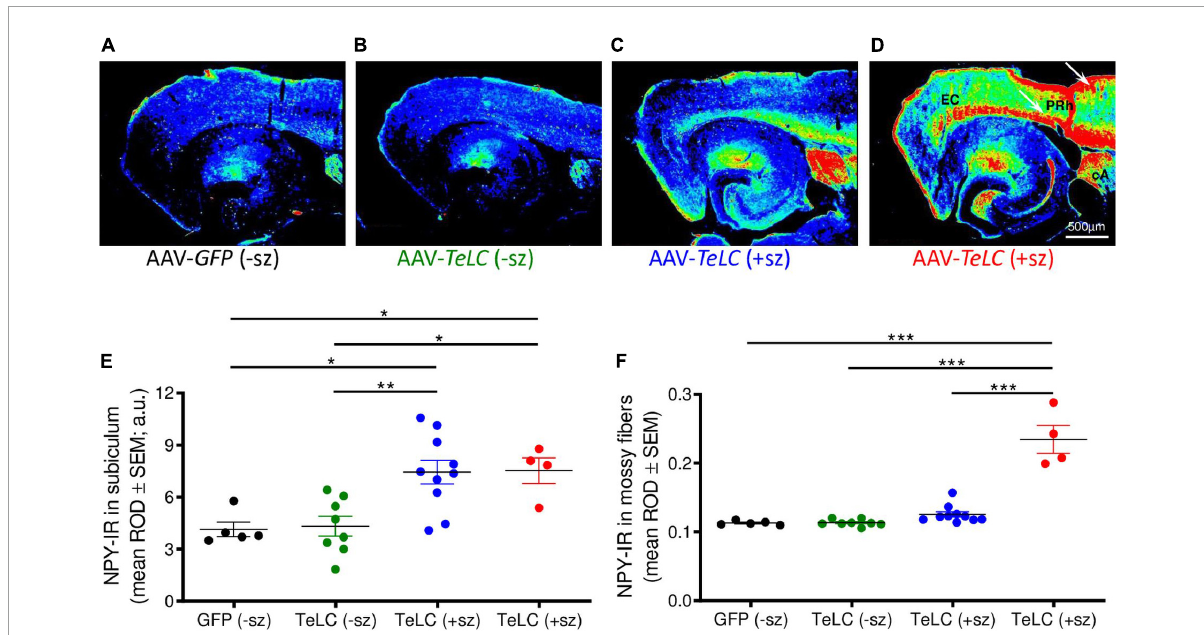
FIGURE4 NPY overexpression in mice experiencing SRS but not in mice with clusters of IS. NPY-IR was assessed in horizontal brain slices at the level of the ventral subiculum/hippocampus in mice 42 days after injection with AAV- GFP or AAV- TeLC , respectively (Experiment 1). Panels (A–D) show false color images of NPY-IR representative for: (A) a control (AAV- GFP -injected, black); (B) representative mouse presenting only IS clusters after AAV- TeLC injection (green, mouse #3425); (C) a mouse that experienced SRS during days 10–30 (blue, mouse #1088); and (D) a mouse with seizures (3) after day 32 (red, mouse #1062). (E,F) Corresponding to the labeling of the images above, the first column in panels (E,F) shows data of control mice without SRS. Note the pronounced increase in NPY-IR in the subiculum, both in mice with seizures up to day 30 (C) and during 10 days before sacrificing (D) . Note also the strong increases in NPY-IR in cortical areas in epileptic mice [ (C) , white arrows in panel (D) ]. Black: AAV- GFP -injected controls ( n = 5); green: AAV- TeLC -injected mice with IS only ( n = 8); blue: mice that experienced SRS only in the first 32 days after AAV- TeLC injection (thus, were at least 10 days seizure-free before sacrificing) ( n = 10); red: mice that experienced SRS within 5 days before sacrificing ( n = 4). Note that the increase in NPY-IR persists in the subiculum of mice that experienced SRS only at earlier intervals [up to day 32 after vector injection; filled blue circles in panel (E) ]. In contrast, increased expression of NPY-IR was observed in the dentate gyrus only in mice that showed SRS also within the last 5 days before sacrificing [filled red circles in panel (F) ]. Letters in panel (D) : EC, entorhinal cortex, PRh, perirhinal cortex, cA, central amygdala. Statistical analysis was done by two-way repeated-measures ANOVA with Dunnett’s multiple-comparison post hoc test; *** p < 0.001; ** p < 0.01; * p <